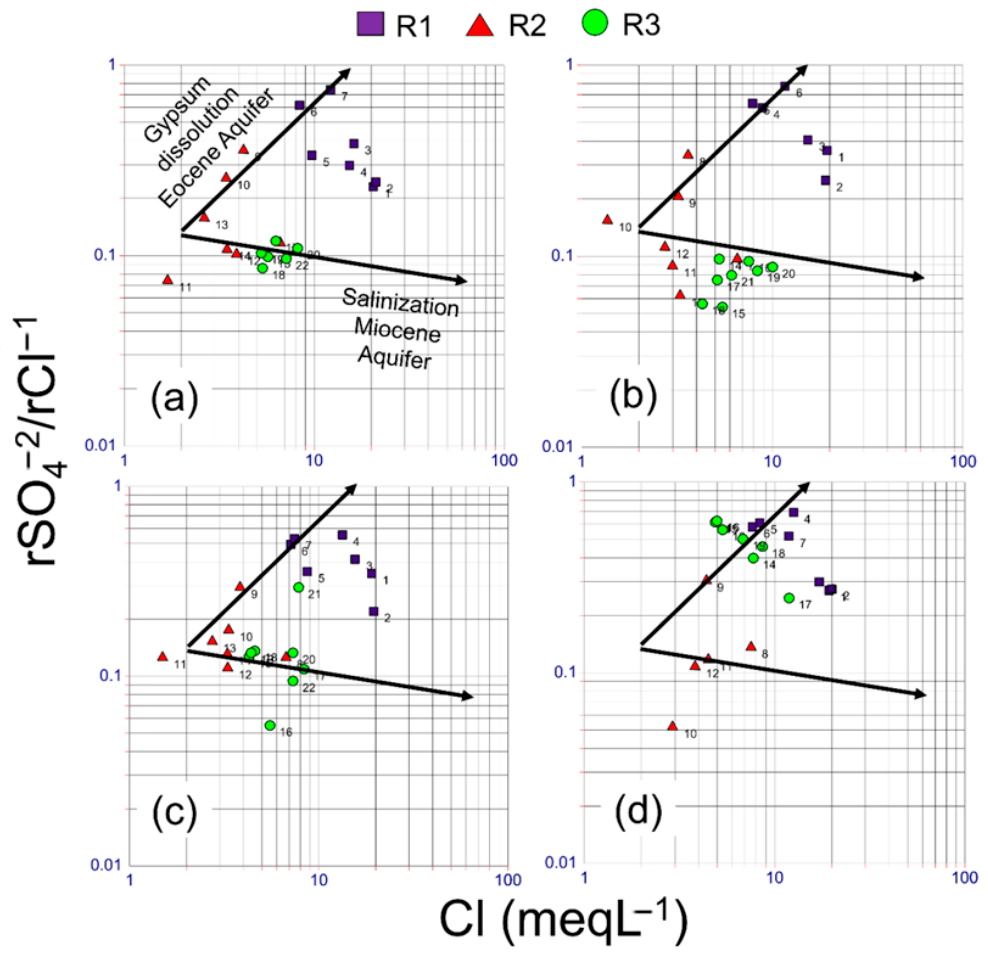
Figure 5. Hydrogeochemical evolution based on the ratio rSO 4 − 2 /rCl − 1 suggested by [19,24]. ( a ) SP1 May–June 2006, ( b ) SP2 October–November 2006, ( c ) SP3 February–March 2007, and ( d ) SP4 April–May